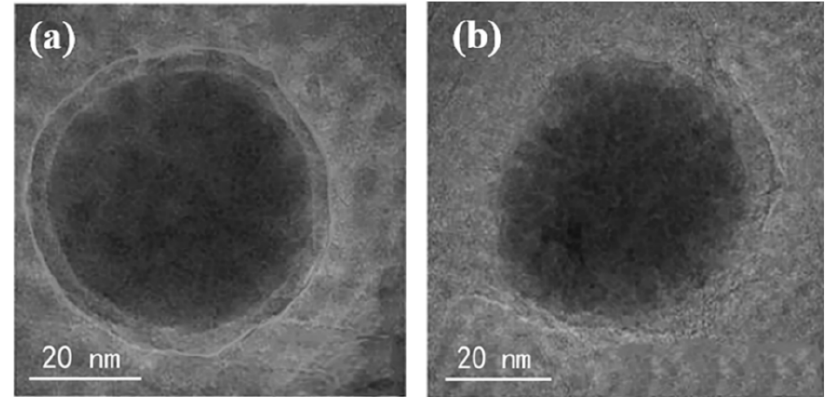
Figure 10. TEM images of nFe ( a ) and nFe/Ni ( b )